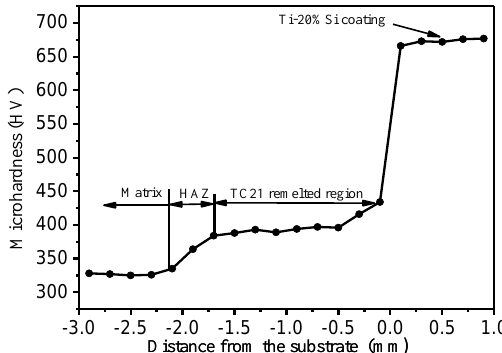
Figure 5. Hardness profile of a laser-cladded specimen.